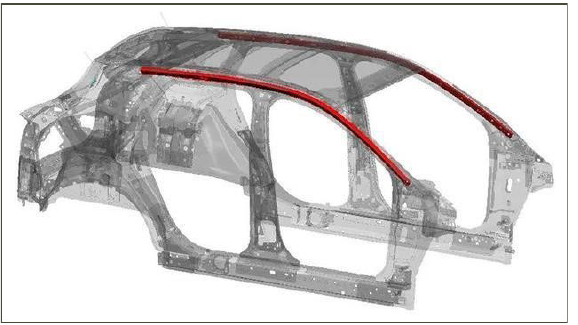
Figure 2. Application of Docol1700M in automobile roof rail pipe [30,31]. This figure is reproduced based on [30,31].